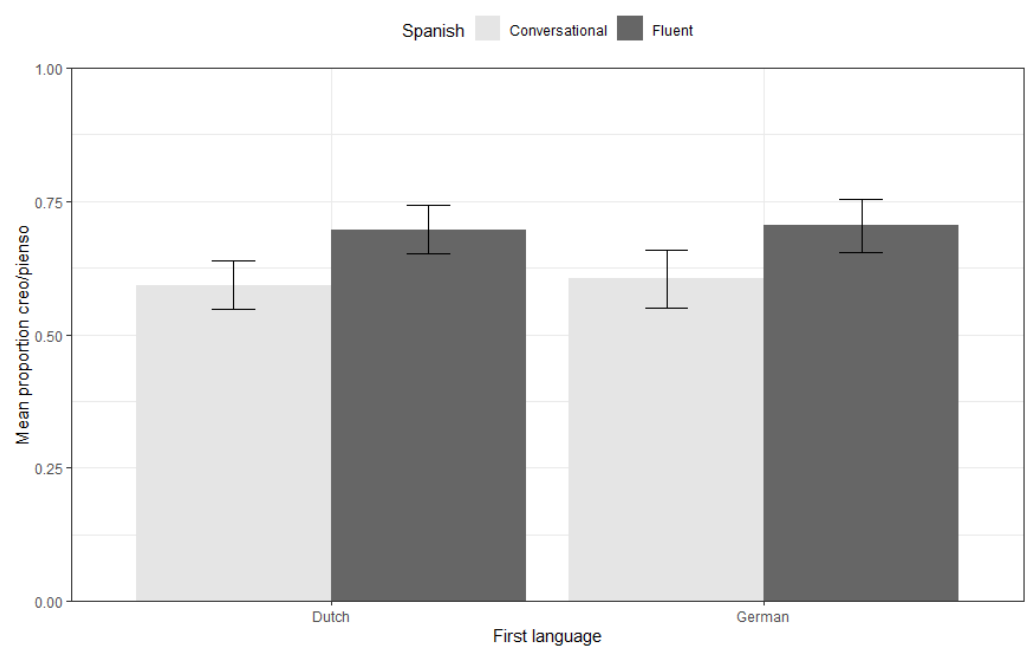
Figure 1. Mean creo que/pienso que proportions of Dutch and German learners of Spanish, per proficiency level, where pienso que = 0 and creo que =